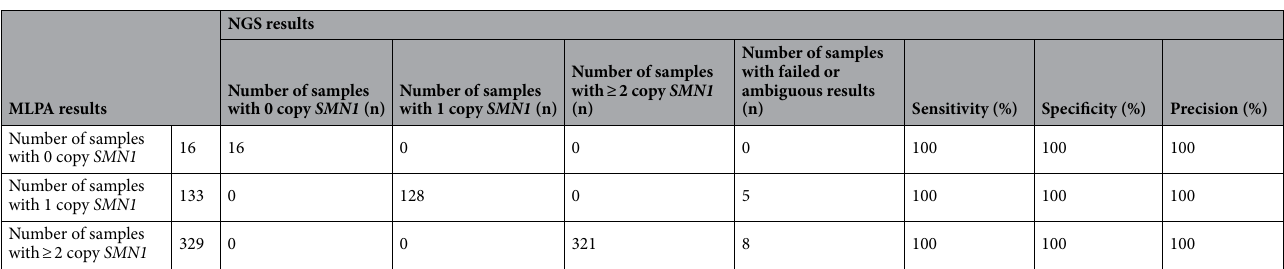
Table 2. The performance of NGS method for SMN1 copy number